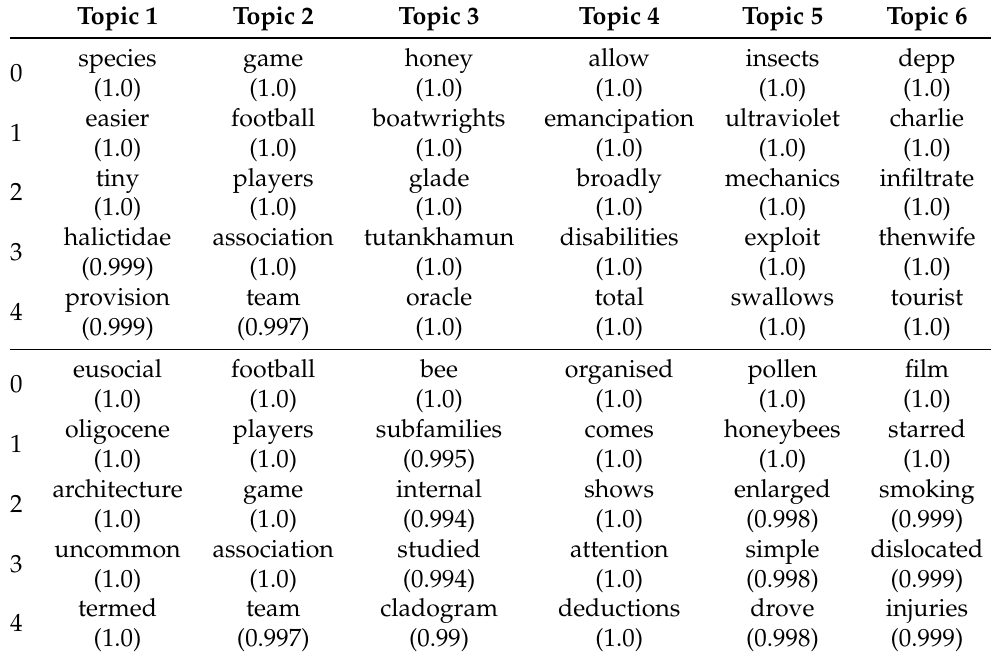
Table 10. For the most significant two words per topic, the four nearest neighbors based on cosine similarity are listed. Matrix A , trained on the wikipedia data as input tensor using multiplicative update